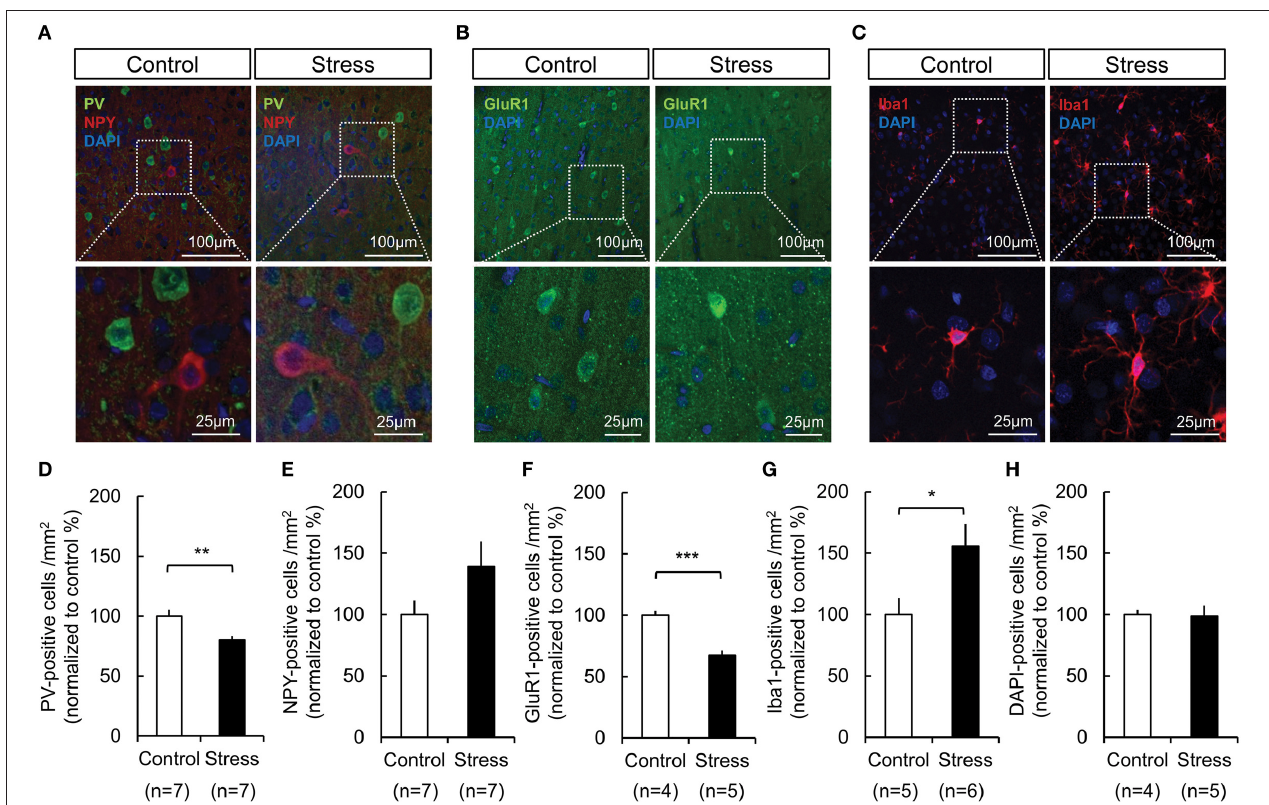
FIGURE 5 | Changes in the expression of PV in GABAergic interneurons, GluR-1 in neurons, and microglial activation in the somatosensory cortex of control and 3-week restraint-stressed rats. (A) Representative images of PV-positive cells (green), NPY-positive cells (red), (B) GluR-1-positive cells (green), and (C) Iba1-positive microglial cells (red). All nuclei are stained using DAPI. The images in the white dashed box are magnified in the lower image. The number of PV- labeled cells (D) , NPY- labeled cells (E) , GluR1- labeled cells (F) , Iba1- labeled cells (G), and DAPI- labeled nuclei (H) in both animal groups were counted (PV, parvalbumin; NPY, neuropeptide Y; DAPI, 4 ′ ,6-diamidino-2-phenylindole; GluR1, glutamate receptor 1; Iba1, ionized calcium binding adaptor molecule 1, Independent t -test, * p < 0.05 ; ** p < 0.01 ; *** p < 0.001 ).